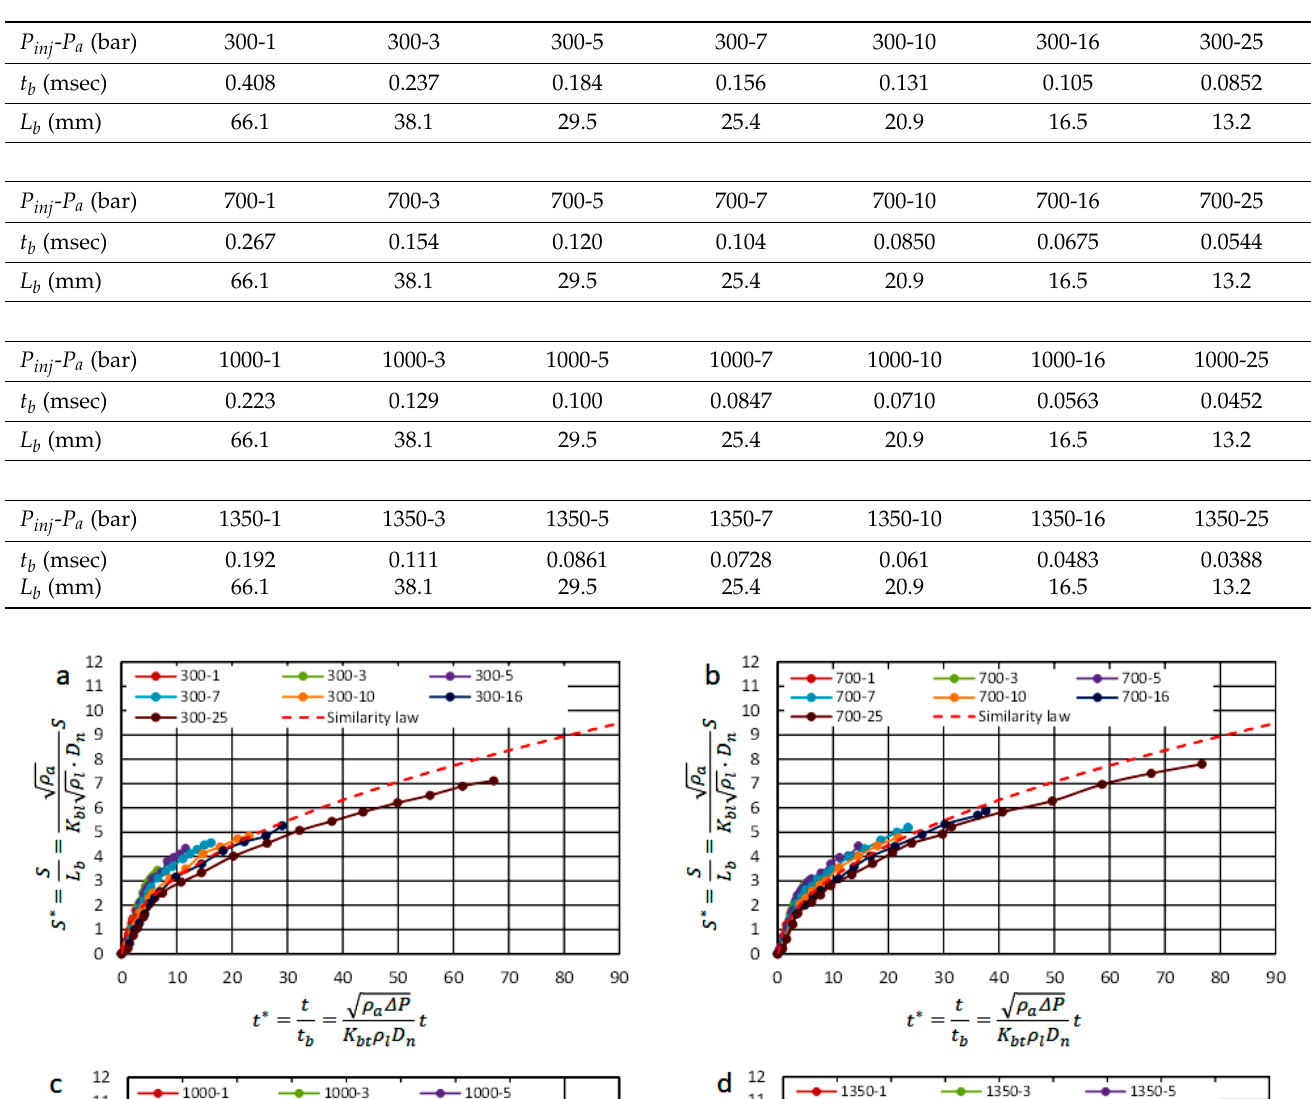
Table 4. Breakup time and breakup length of validation sprays.